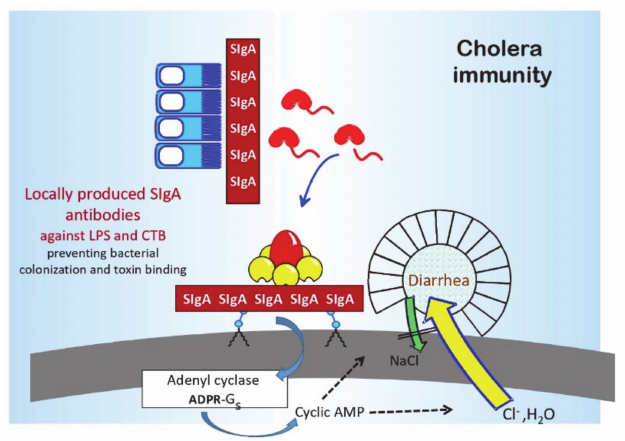
Figure 2. Protective immunity in cholera. Immune protection after infection or oral immunization is mediated mainly, if not exclusively, by locally produced SIgA antibodies that are directed against the cell surface LPS O antigen (predominantly against the A epitope defining the O1 serogroup, but also against the serotype-specific epitopes B (Ogawa) and C (Inaba) and the cholera toxin (mainly against the B subunit pentamer), and which inhibit bacterial colonization and toxin binding,